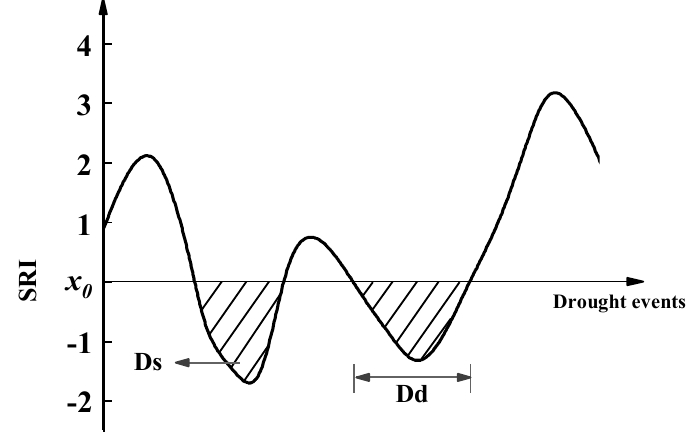
Figure 3. Schematic diagram of the run theory used to determine drought duration (Dd) and drought severity (Ds) [55].